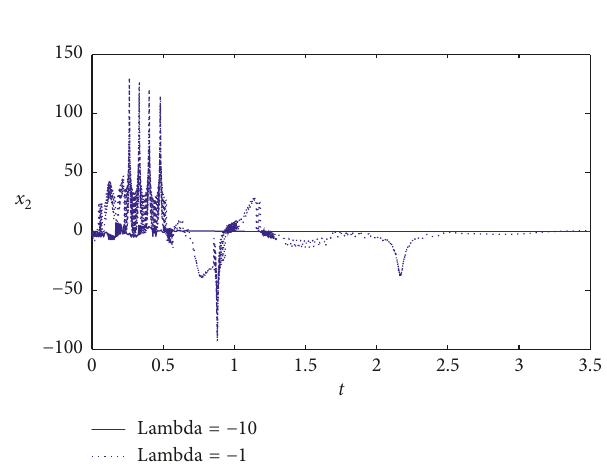
Figure 2: The time response of state x x